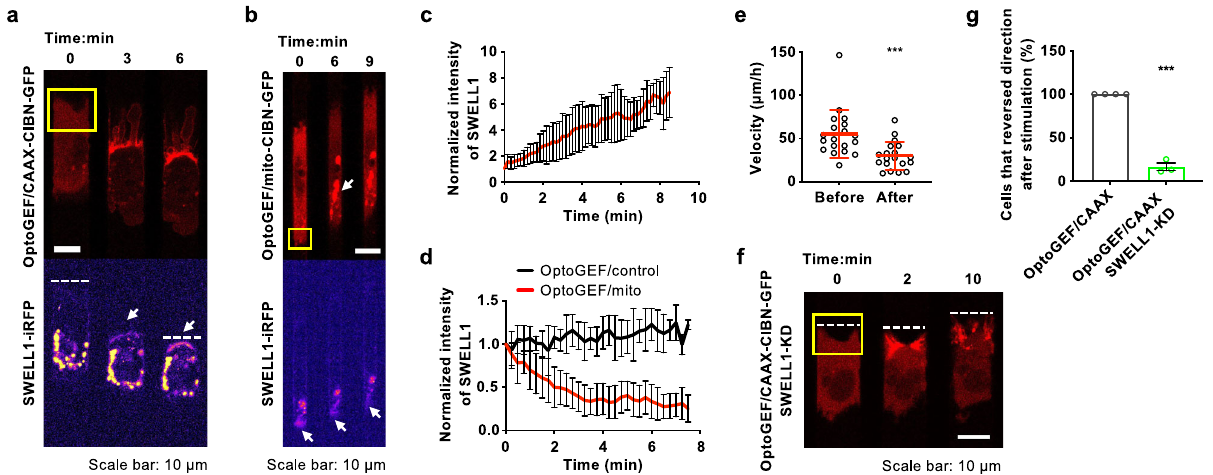
Fig.4|RhoAactivityregulatesSWELL1polarization.a , b Time-lapsemontageof MDA-MB-231 cells expressing SWELL1-iRFP, OptoGEF-RhoA,and a CAAX-CIBN-GFP or b mito-CIBN-GFPinside a 10 μ m-or b 3 μ m-widechannels.Lightstimulationwas applied in a region enclosed by yellow boxes just after t=0. a OptoGEF-RhoA enrichment at the cell front is accompanied by local SWELL1 accumulation (white arrow), which causes migration direction reversal. The position of the cell ’ s “ old ” leadingedgeisdepictedbywhitedashlinesin a . b Optogeneticdownregulationof RhoA activity at the cell rear is accompanied by Rho-GEF accumulation in mito- chondria (white arrow, top), and a reduction of SWELL1 intensity at the cell rear (white arrow, bottom). c Normalized SWELL1-iRFP intensity at the “ old ” cell front (or “ new ” cell rear) after optogenetically stimulating cells with optoGEF-RhoA and CAAX-CIBN-GFP. Data represent the mean±SD for n =23 cellsfrom 5 independent experiments. d Normalized SWELL1-iRFP intensity at cell rear after stimulating optoGEF-RhoAinthe presence(red)or absence(black;control)of mito-CIBN-GFP. Data represent the mean±SD for n =25 cells (red) and n =9 cells (black) from 6